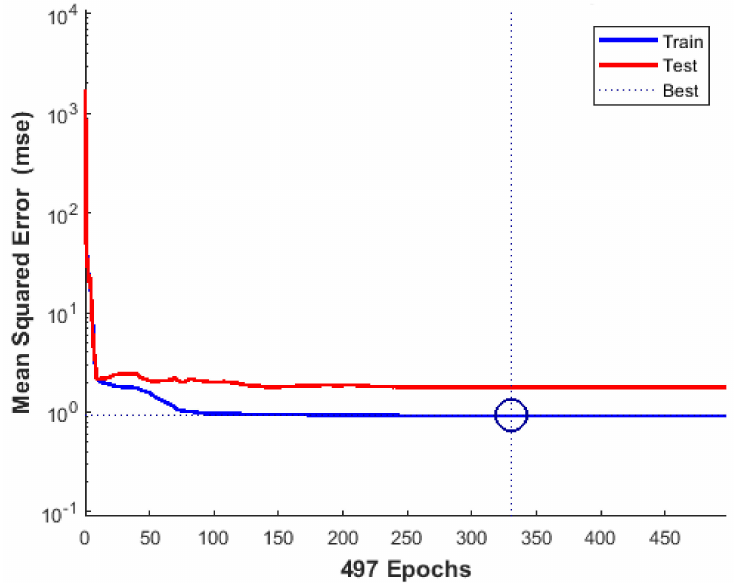
Figure 8. Mean squared error performance of three-layer BRANN for GPC compressive strength